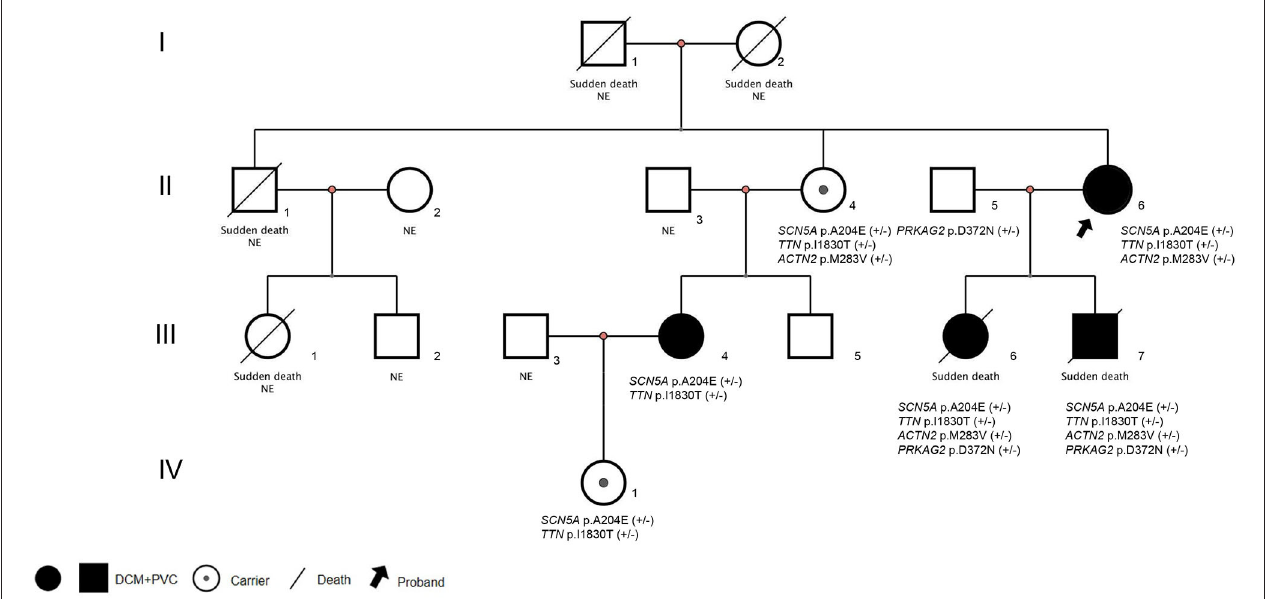
FIGURE 1 | Pedigrees and diagnosis of the families assessed. Squares indicate male family members, circles indicate female family members. NE:Genomic DNA was not examined. ( + /-): Haplotype. DCM, Dilated cardiomyopathy; PVC, Premature ventricular